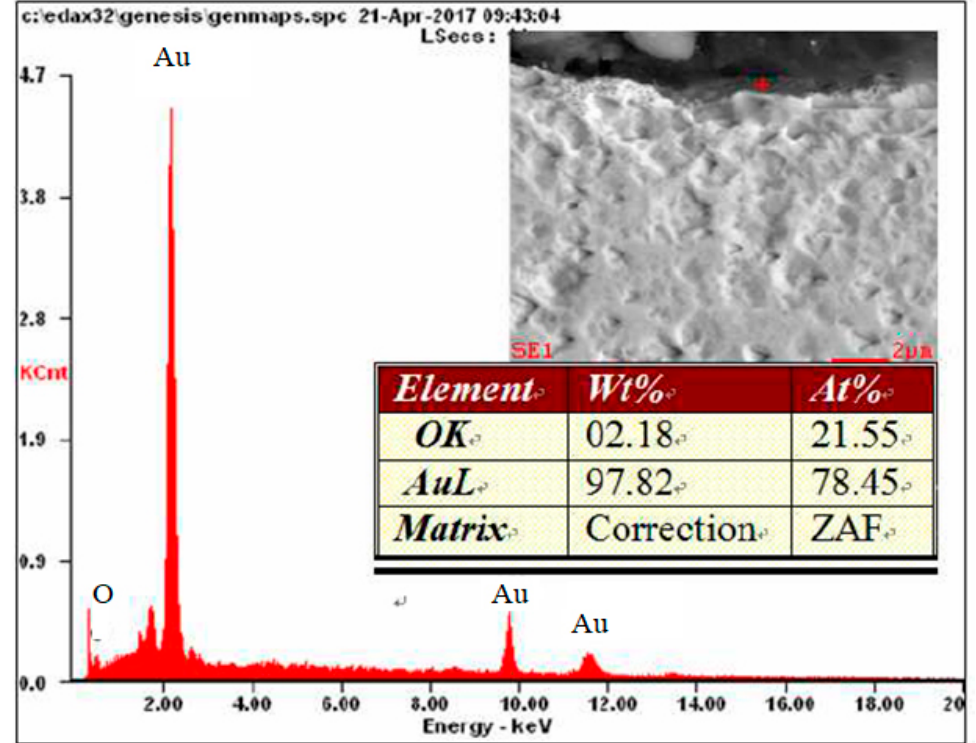
marked in the photomicrographs.